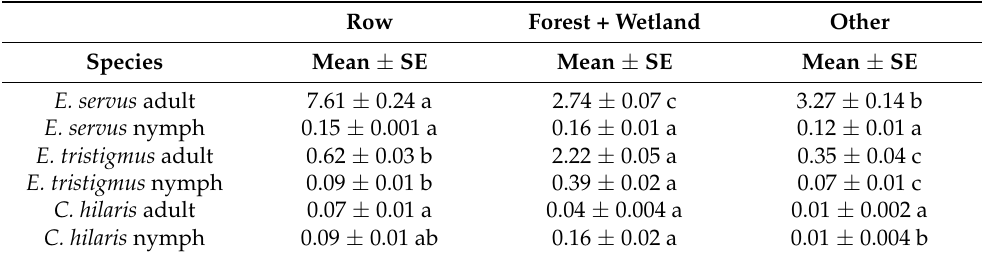
Table 1. Mean ± SE number of adult and nymph Euschistus servus (Say), Euschistus tristigmus (Say), and Chinavia hilaris (Say) stink bugs captured in pheromone-baited traps by habitat. Row Forest + Wetland Other Species Mean ± SE Mean ± SE Mean ± SE 7.61 ± 0.24